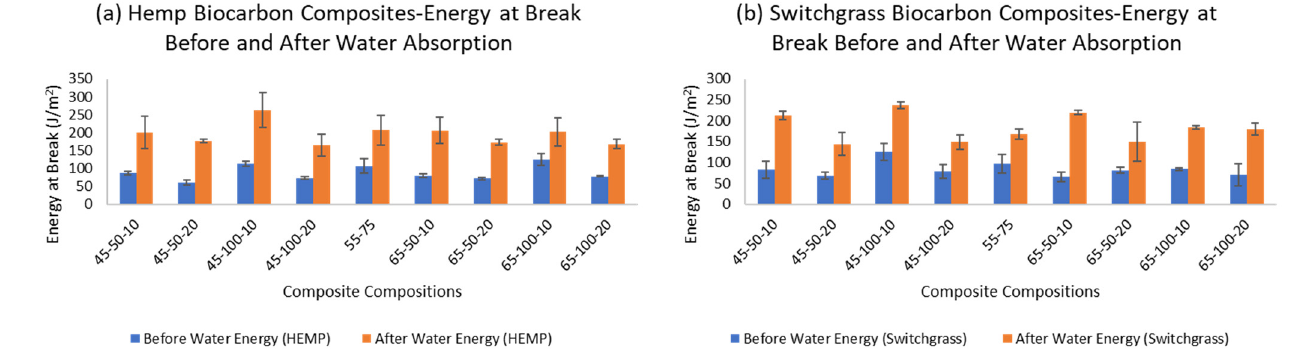
Figure 10. Energy at break of hemp composites before and after the water absorption test with ( a ) hemp biocarbon and ( b ) switchgrass biocarbon.